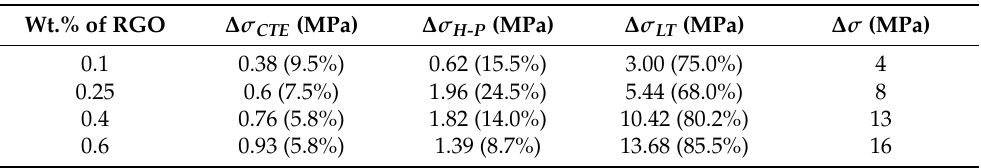
Table 2. Calculated contributions and proportion of each strengthening mechanism to the yield strength of RGO/ZK61 composites.